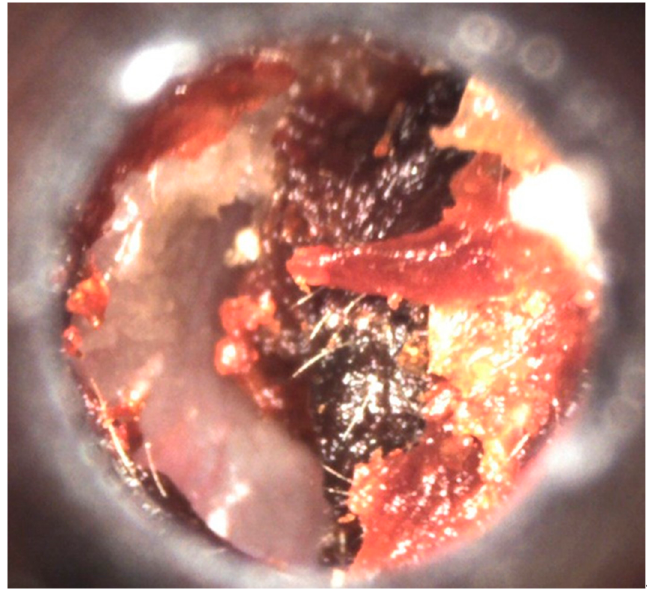
Figure 2. Ear canal partially blocked by cerumen in a 3-year-old child. Visualization of the whole TM, including light reflex, ossicles, and mobility, requires that more than 75% of the ear canal diameter must be free [26]. More than 70% of children have cerumen and, among these, more than 40% have an ear canal obstruction ≥ 50%.